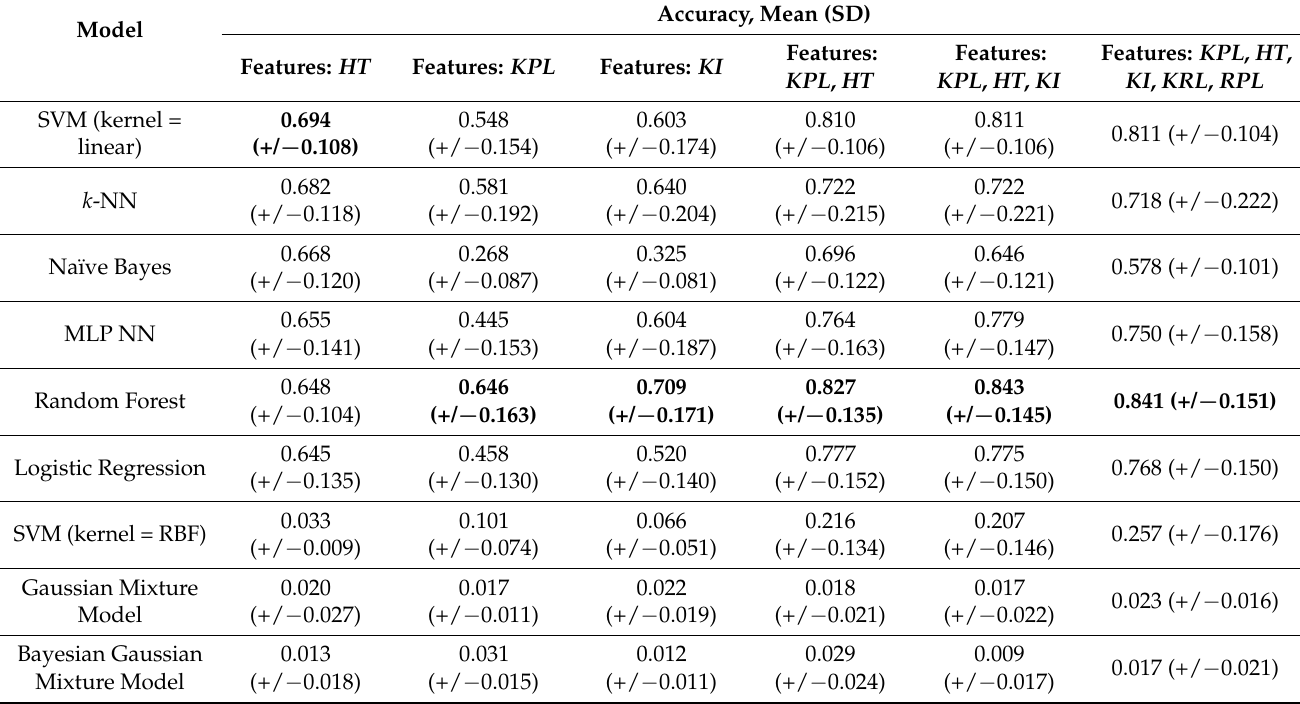
Table 7. Identification accuracy of different models using different